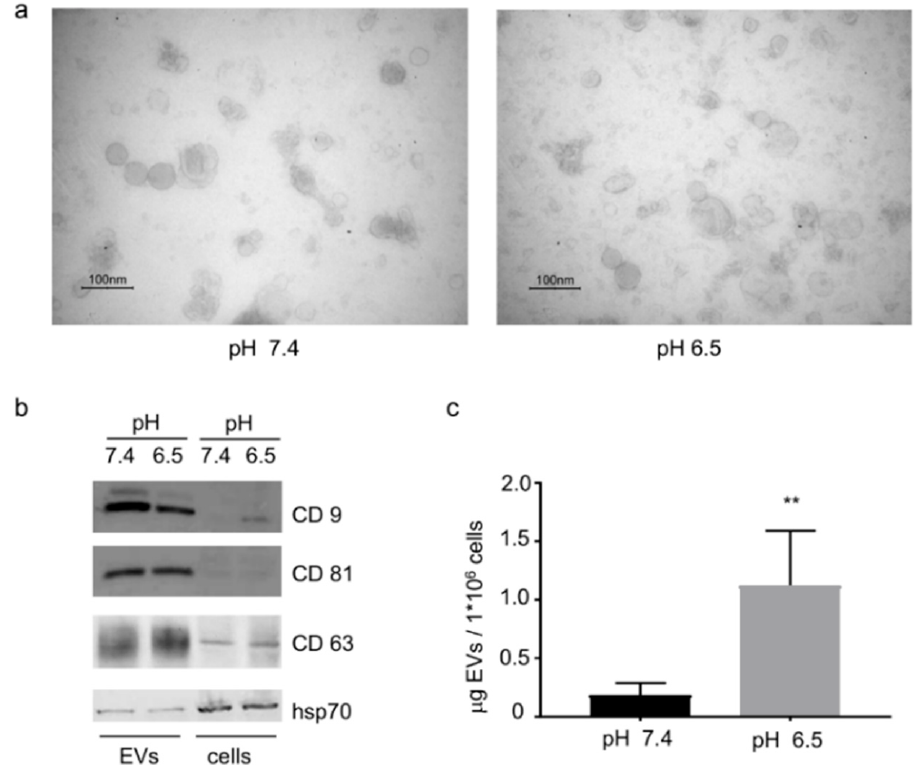
Figure 1. Osteosarcoma (OS)-derived extracellular nanovesicles (EVs) characterization. ( a ) Representative transmission electron microscopy images of EVs, isolated from medium conditioned